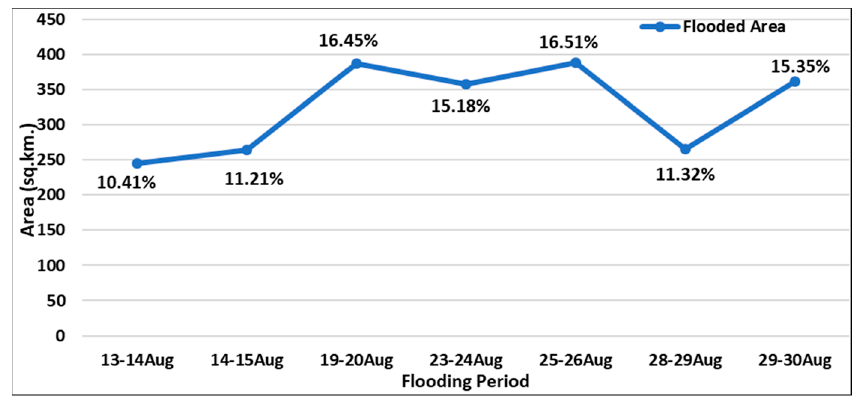
Figure 5. Flood inundation area (sq.km) over Katihar district during 13–30th August 2017. The total geographical area of the district is 2351 sq.km.